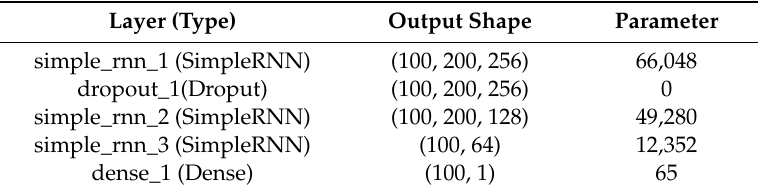
Table 2. LSTM Network Model Overview.